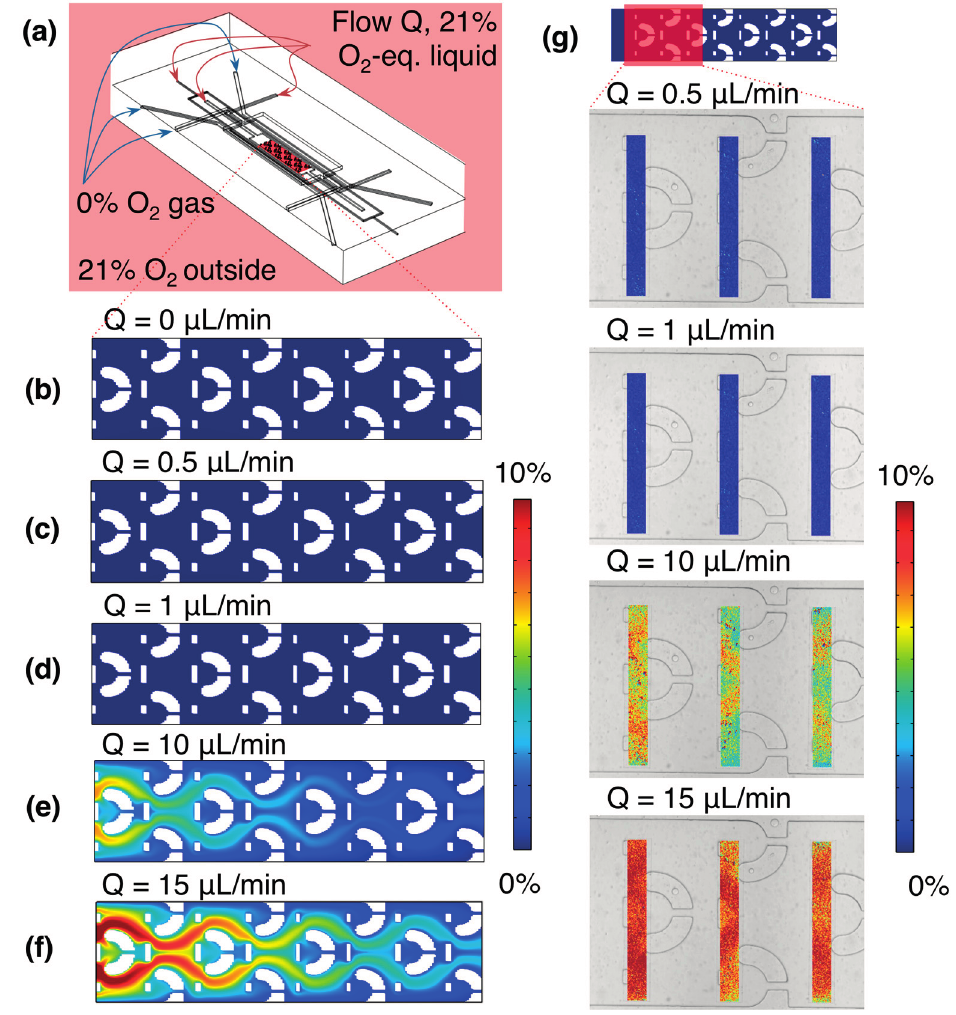
Figure 5. Simulated and experimental oxygen levels within the microfluidic device, at various rates of fluid flow in the cell culture channel and bubble removal/hydration channels (the same rate supplied to all three channels). ( a ) Simulation geometry, showing the region analyzed (a 2-D slice near the channel bottom, through the region of the channel designed to contain cell cultures: the “cell-containing channel region”), as well as the input oxygen conditions; ( b ) Simulated oxygen levels within the channel at 0 µL/min fluid flow. Average oxygen level in this region was 0.03%, while the maximum was 0.06%; ( c ) Simulated oxygen levels within the channel at 0.5 µL/min fluid flow. Average oxygen level in this region was 0.03%, while the maximum was 0.05%; ( d ) Simulated oxygen levels within the channel at 1 µL/min fluid flow. Average oxygen level in this region was 0.03%, while the maximum was 0.05%; ( e ) Simulated oxygen levels within the channel at 10 µL/min fluid flow. Average oxygen level in this region was 2.01%, while the maximum was 7.33%; ( f ) Simulated oxygen levels within the channel at 15 µL/min fluid flow. Average oxygen level in this region was 3.86%, while the maximum was 11.2%; ( g ) False-colour images of measured oxygen profiles near the chip inlet, at 0.5, 1, 10, and 15 µL/min fluid flow, overlaid upon a brightfield microscope image of the channel. Average oxygen levels in the sensor patch regions were 0.01%, 0.009%, 6.5%, and 9.9% at 0.5, 1, 10, and 15 µL/min fluid flow,